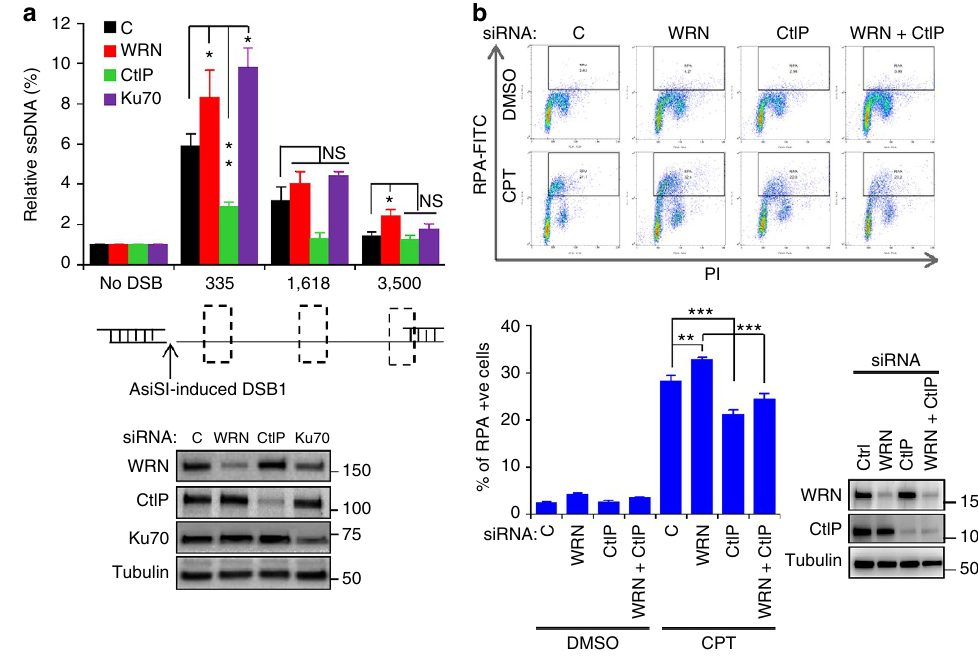
Figure 5 | Deficiency of WRN enhances resection at DSBs. ( a ) Quantitation of 5 0 end resection in WRN knockdown AID-DIvA cells. Bar graph showing the extent of ssDNA generated by end resection at Asi SI-induced DSBs. Three days post siRNA-transfection, cells were treated with 4-OHT for 4h and quantitative PCR was performed to amplify the ssDNA at a specific DSB site. Immunoblots indicate the protein knockdown levels in siRNA transfected AID-DIvA cells. Cartoon below the bar graph represent the DSB site on chromosome 1 along with regions (dotted boxes) used to amplify the ssDNA generated from resection. Error bars represent SEM from four independent biological experiments. ( b ) ssDNA-bound RPA in WRN knockdown U2OS cells. Control, WRN and CtIP depleted cells treated with DMSO or camptothecin (CPT) were detergent extracted prior to fixation and staining with RPA and propodeum iodide (PI) and analysed by flow cytometry. Representative dot plots of RPA and PI stained cells are shown. Graph represents ssDNA-bound RPA from three biological experiments. Error bars indicate standard deviation. P value, *, o 0.05; **, o 0.01; ***, o 0.001; NS, not significant. Immunoblots indicate protein levels in siRNA transfected